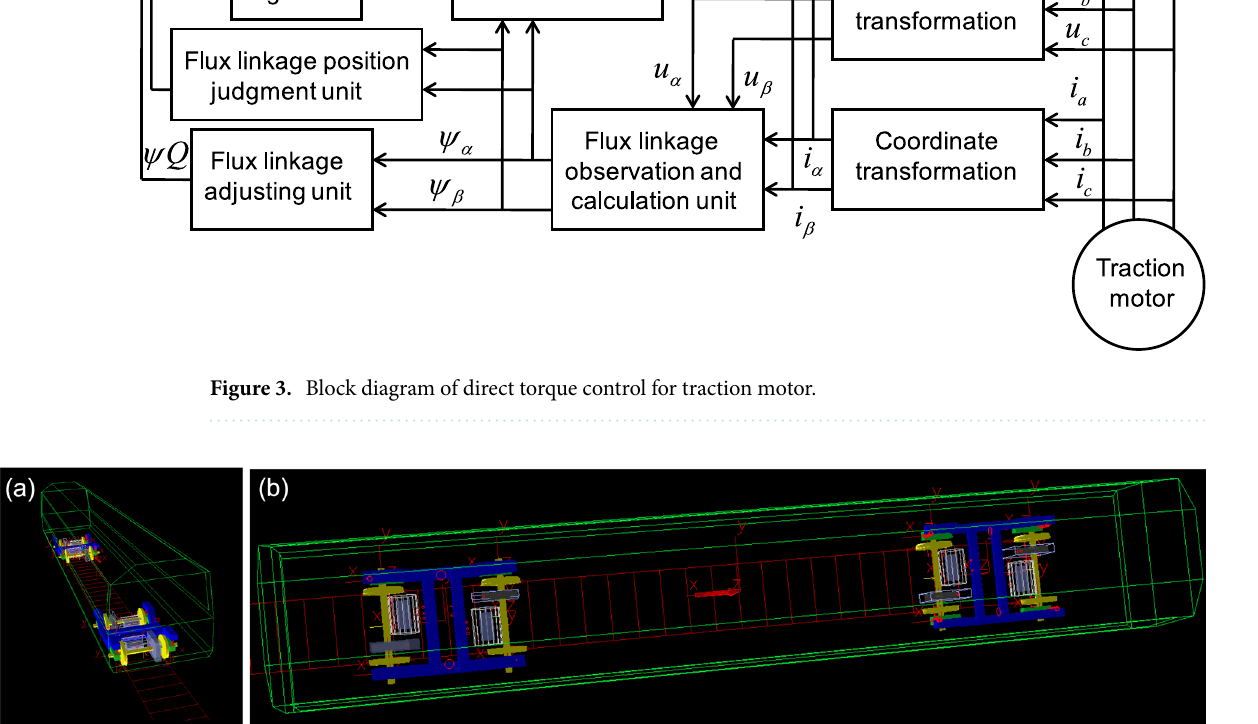
Figure 4. Side view (a) and top view (b) of the vehicle dynamics model with transmission